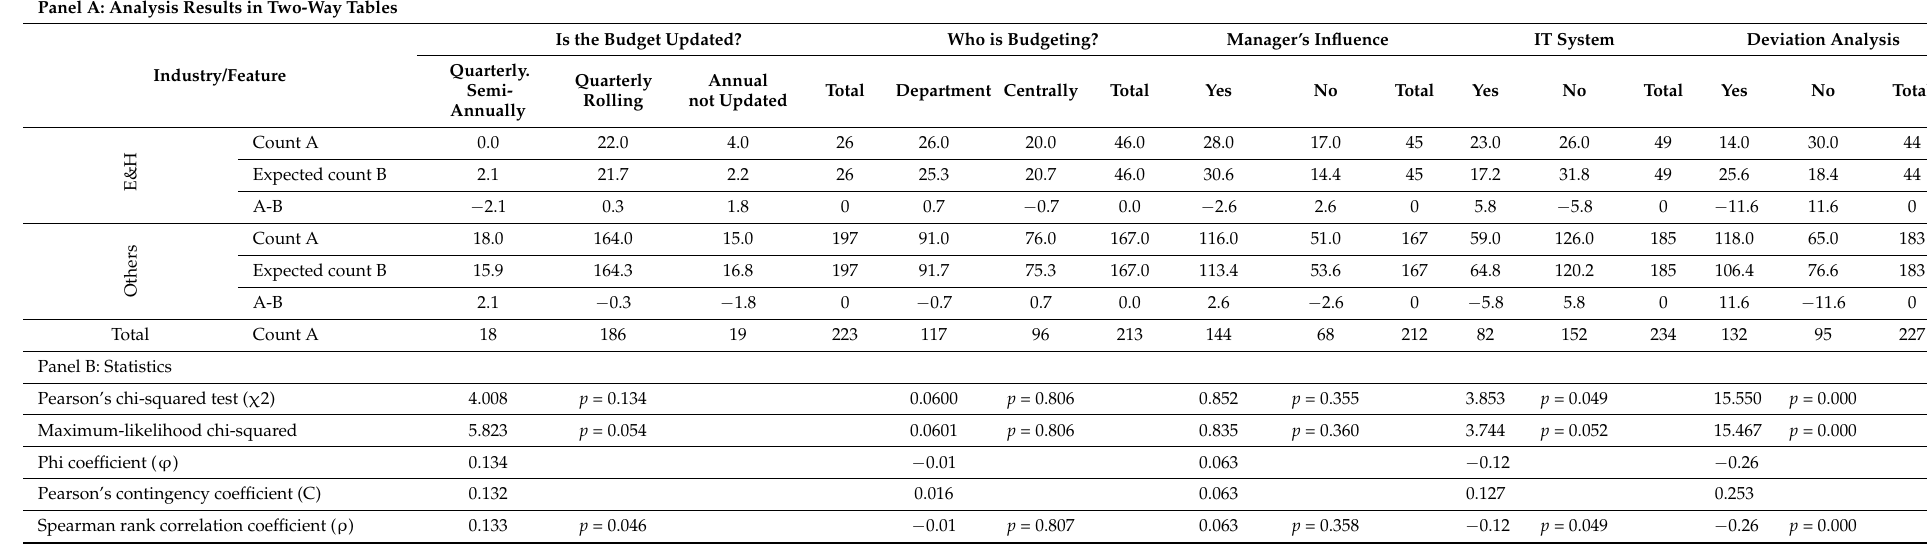
Table 13. Characteristics of budgeting processes in the surveyed